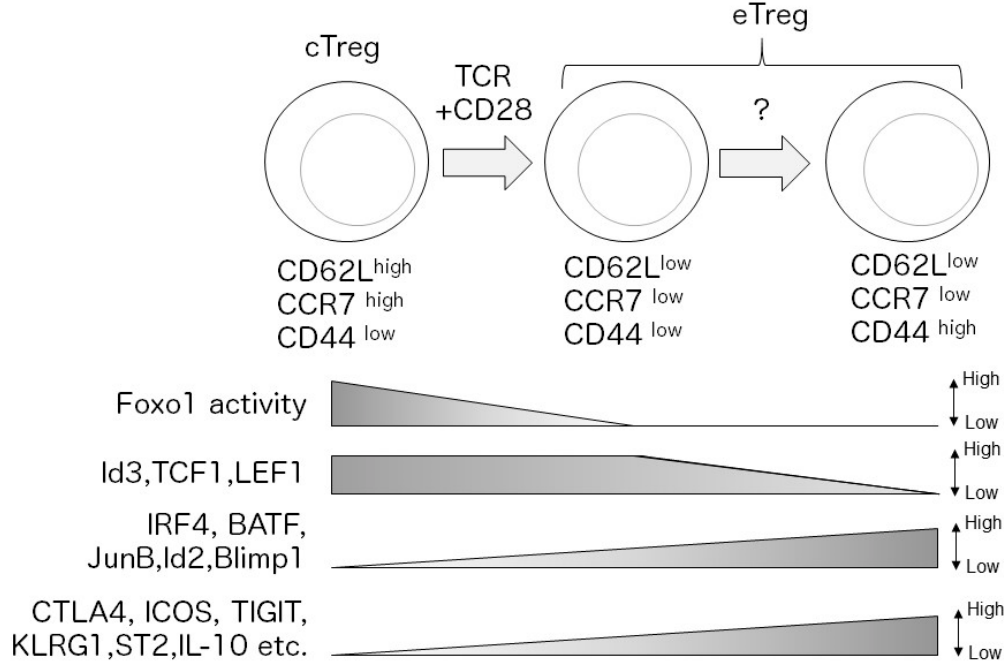
Figure 1. Upon antigen stimulation, central Treg (cTreg) cells (CD62L hi CCR7 hi CD44 lo ) differentiate into effector Treg (eTreg) cells (CD62L lo CCR7 lo CD44 hi ) depending on TCR and CD28 signaling. After activation, TCR-dependent transcription factors, such as interferon regulatory factor 4 (IRF4), are induced and regulate the eTreg transcriptional program. In contrast, Foxo1 is inactivated by Akt-signaling, which decreases expression of cTreg-related molecules. Loss of Id2, transcription factor 1 (TCF1), and lymphoid enhancer binding factor 1 (LEF1) expression is a signature of mature eTreg cells. Mature eTreg cells highly express immune suppressive molecules, such as cytotoxic T cell antigen 4 (CTLA4) and inducible T cell costimulator (ICOS).